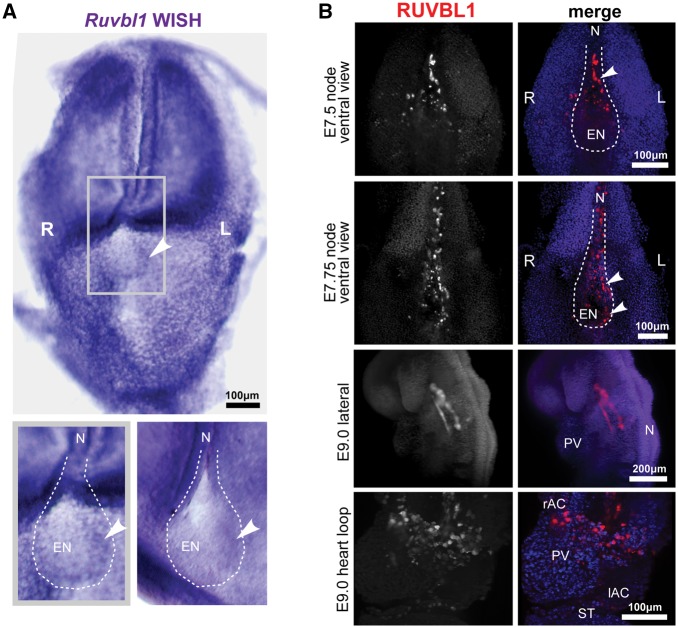
Left-sided asymmetric expression of RUVBL1 at the mouse embryonic node: (A) whole-mount in situ hybridization (WISH) of Ruvbl1 probes for whole-mount head-fold stage wild-type C3H/HeH mouse embryos showing widespread, ubiquitous Ruvbl1 expression and left-sided asymmetric distribution at the embryonic node. Grey frame indicates magnified inset (lower left) with a second example at lower right, with Ruvbl1 expression indicated by arrowheads. Scale bar = 100 μm. (B) Light-sheet microscopy images of whole-mount immunofluorescence for RUVBL1 (red) and DAPI (blue) in the wild-type C57BL/6 mouse E7.25 and E7.5 (late head fold and 2–4 somite stage) embryonic node, and E9.0 (6–8 somite stage) vasculature and heart loop. Left (L) and right (R) sides are indicated. RUVBL1 is asymmetrically distributed at the murine embryonic node (upper two panels). RUVBL1 is present in a widespread distribution throughout the atrial chambers, primitive ventricle and developing vasculature (lower two panels). Scale bars = 100 or 200 μm, as indicated. Abbreviations: rAC and IAC, right and left atrial chambers; EN, embryonic node; L, left; N, notochord; PV, primitive ventricle; R, right; ST, septum transversum.